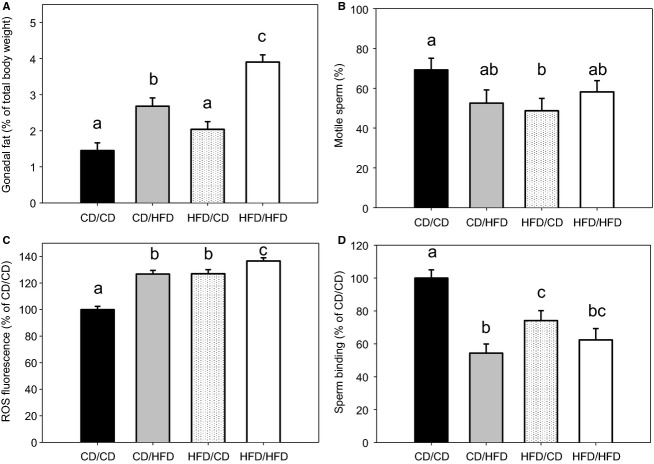
Reproductive measures of F1 male offspring fed a CD/HFD fathered by CD/HFD F0 males. (A) Gonadal fat as a proportion of total body weight, (B) proportion of motile sperm, (C) reactive oxygen species (ROS) as a proportion of CD/CD (i.e., CD/CD set to 100%; using fluorescence readings from an average of n = 41.5 ± 6.6 sperm per group) as determined by DCFDA fluorescence and (D) sperm binding as a proportion of CD/CD (i.e., CD/CD set to 100%; using sperm binding to an average of 34.3 ± 4.0 oocytes per group) are depicted for F1 males for the groups CD/CD (CD fed F1 sired by a CD fed F0; n = 14), CD/HFD (HFD fed F1 sired by a CD fed F0; n = 14), HFD/CD (CD fed F1 sired by a HFD fed F0; n = 20) and HFD/HFD (HFD fed F1 sired by a HFD fed F0; n = 19). Data are presented as means ± SEM and different letters represent statistically distinct groups (P < 0.05).